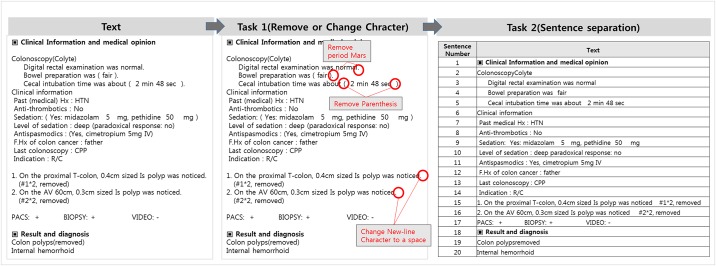
Text pre-processing.